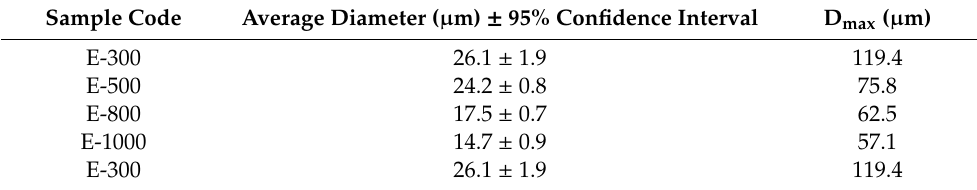
Figure 6. Size distribution of microcapsules prepared at different mixing rates ( a ) without CNTs, and ( b ) with 0.5 wt % CNTs. Table 3. Effect of mixing speed on average and maximum microcapsule diameters at 0 CNT content. Sample Code